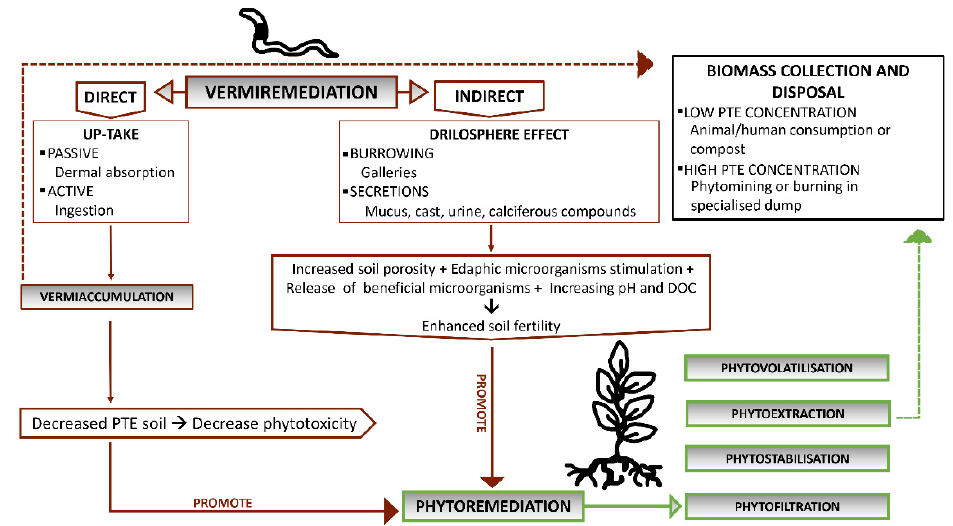
Figure 2. Schematic representation of the processes involved in vermiremediation for PTEs with correlation to phytoremediation and the possible fate of biomass.